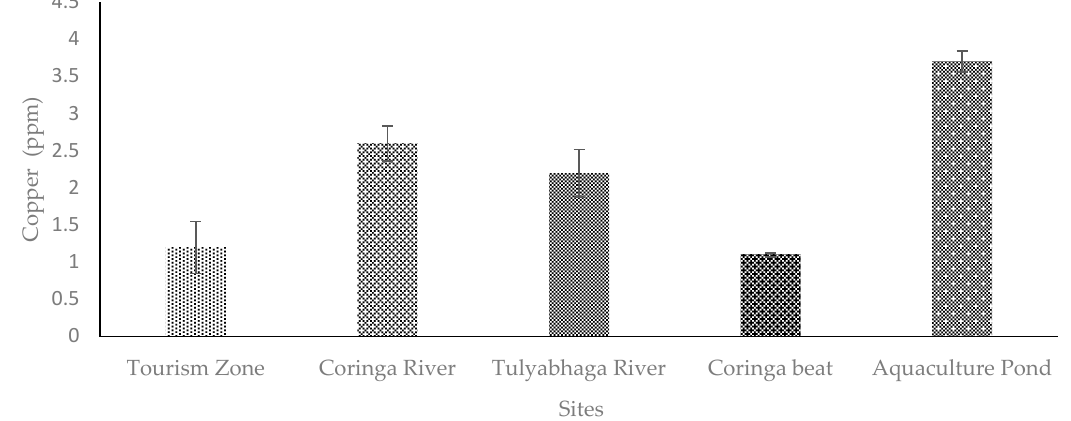
Figure 4. Level of Cu examined in fishing cat scats from different sites of Coringa Wildlife Sanctuary, Andhra Pradesh, India. [Tourism zone (Site 1), Coringa river (Site 2), Tulyabhaga river (Site 3), Coringa beat (Site 4), and Aquaculture pond (Site 5)]. [Bar indicates mean and the line indicates SE; n = 6].